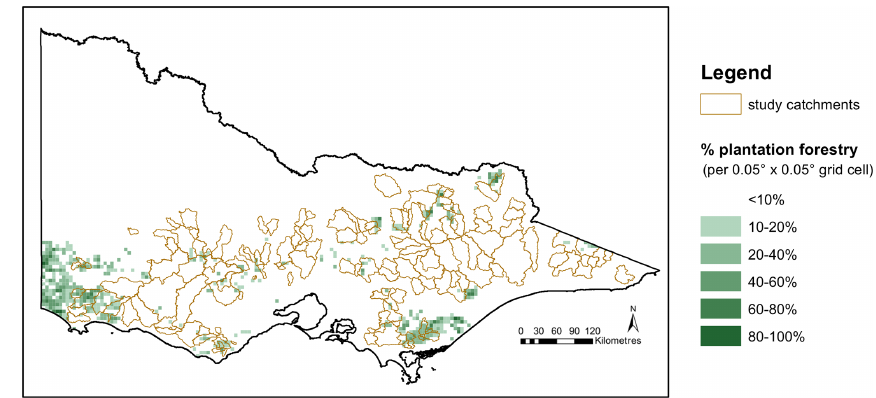
Figure E3. Spatial distribution of plantation forestry in Victoria in 2016. Processed from raw data from ABARES (2016).